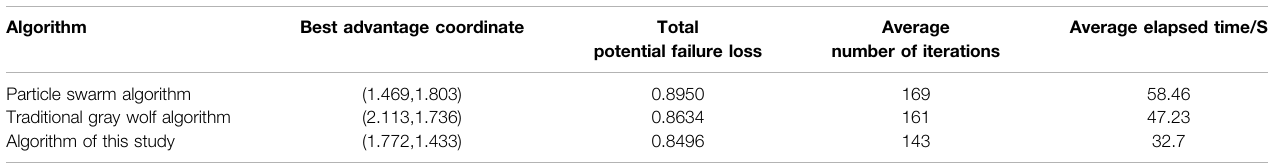
TABLE 1 | Comparison of optimization results of different algorithms.